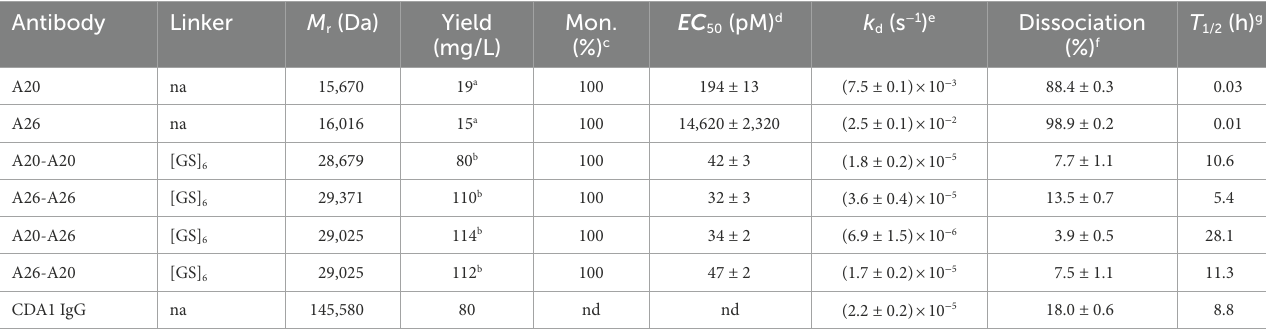
TABLE 1 Biophysical properties of anti-TcdA V H H constructs.